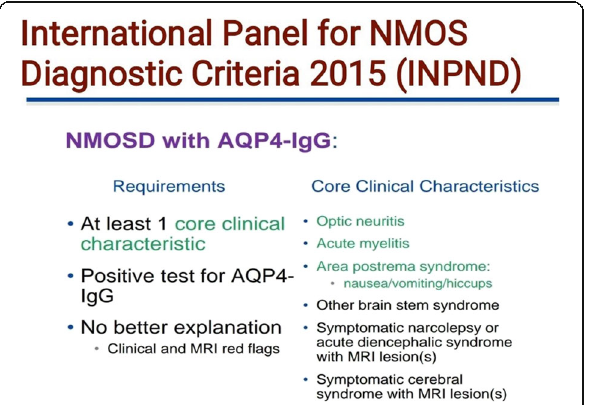
Fig. 1 International consensus diagnostic criteria for seropositive neuromyelitis óptica spectrum disorders [16]. NMOSD neuromyelitis spectrum disorders, AQP4-IgG aquapurine-4 immunoglobulin G, ON optic neuritis